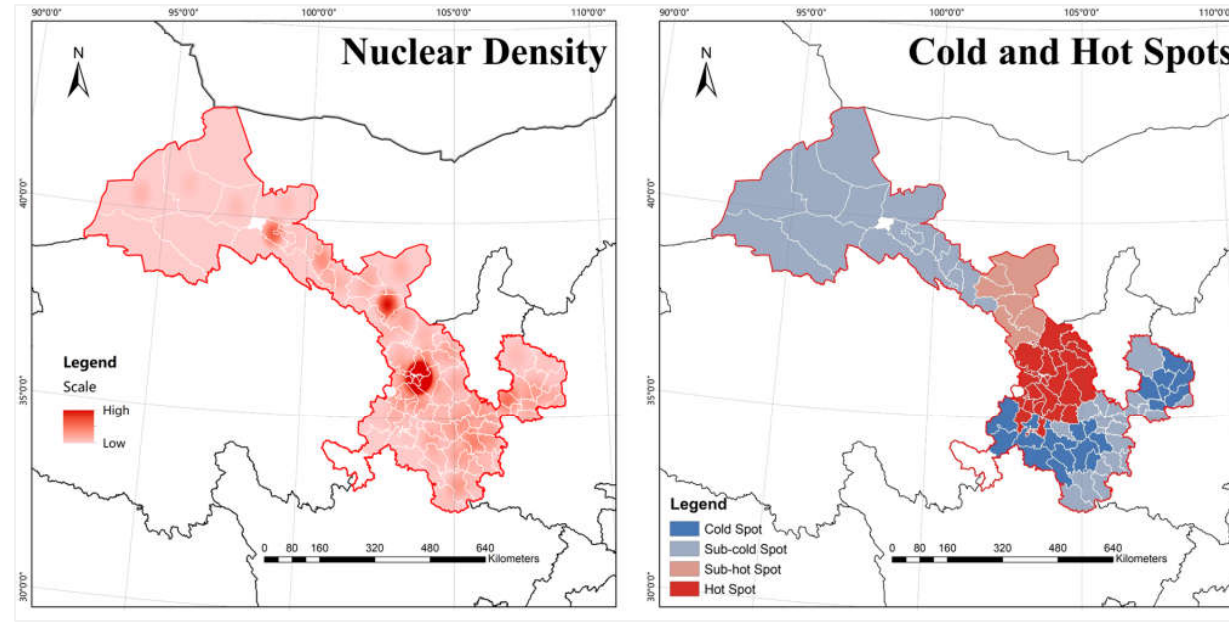
Buildings 2022 , 12 , x FOR PEER REVIEW Figure 5. Spatial analysis on industrial scale of real estate in Gansu. Figure 5. Spatial analysis on industrial scale of real estate in Gansu.